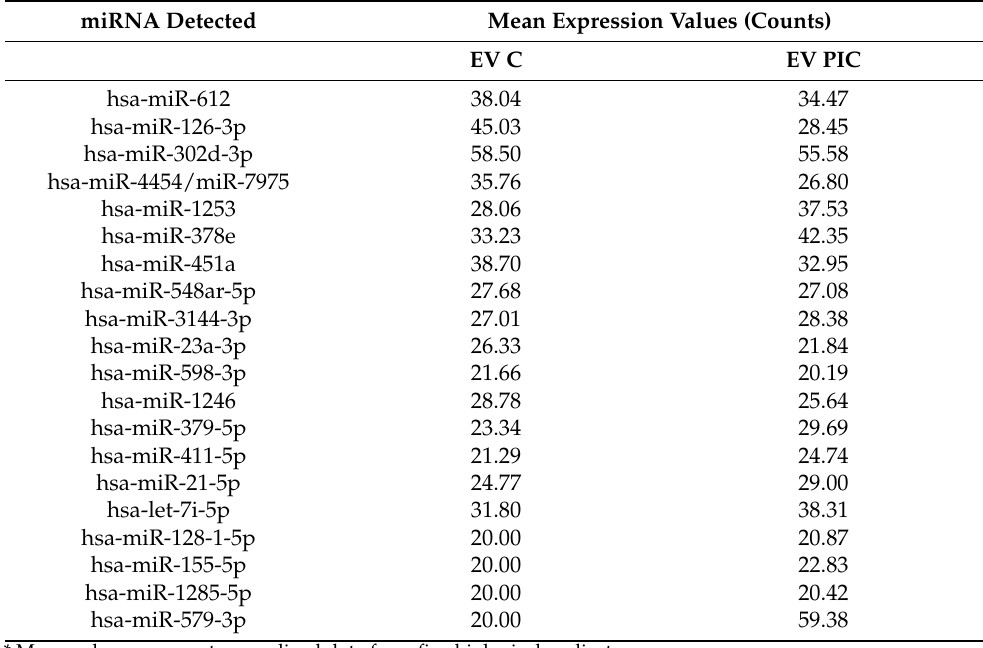
Table 1. miRNA mean values * detected in EV C and EV PIC. miRNA